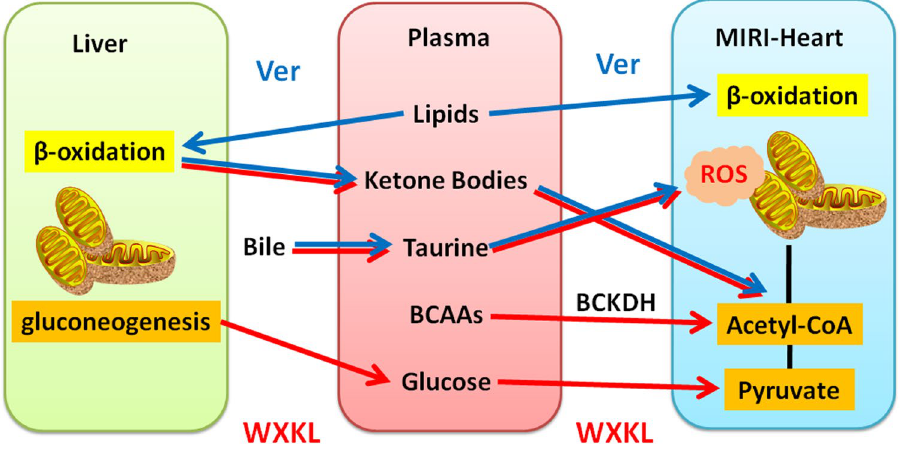
Figure 6. A summary of the metabolic responses of MIRI rats treated by WXKL and